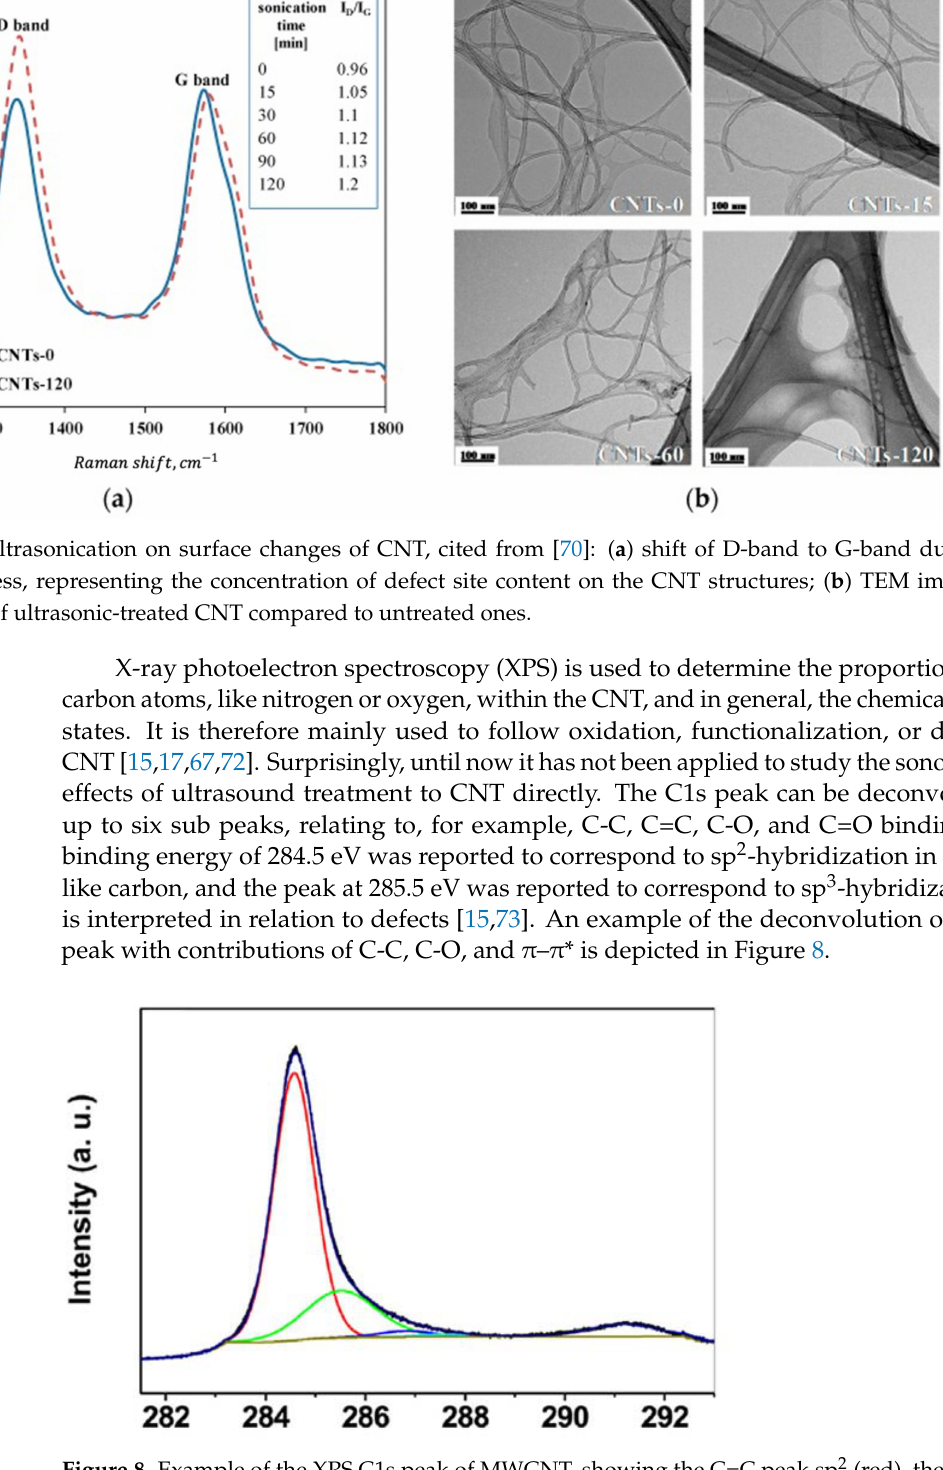
Figure 10. Typical UV–Vis spectrum of MWCNT with the two absorption bands at 253 nm and 970 nm [35].